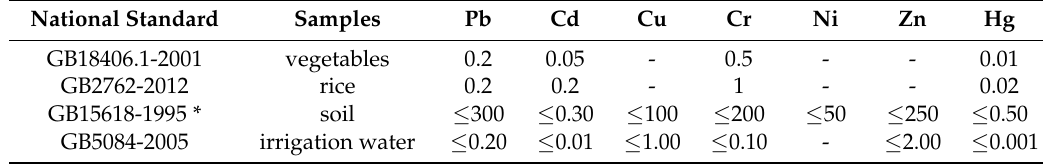
Table 1. The national hygienic standard for food and class II standard for soil in China (mg/kg). National Standard